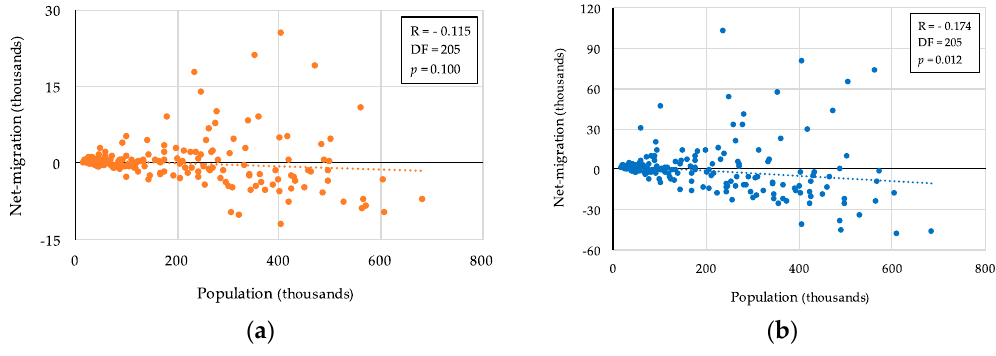
Figure A1. Population in 2010 and observed net migration: ( a ) in 2011; and ( b ) during 2011–2015.